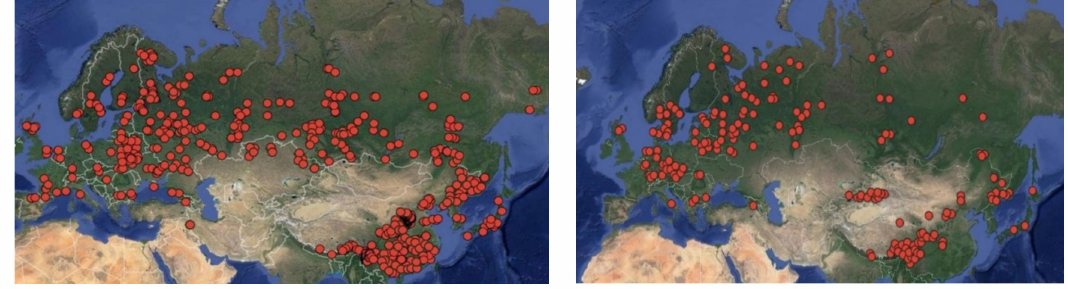
Figure 1. The distribution of 2110 sampling sites of Pinus (on the left ) and 870 sampling sites of Picea (on the right ) on the territory of